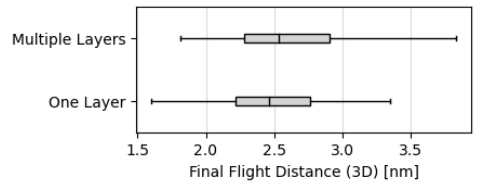
Figure 25. Flight path per aircraft without CR.